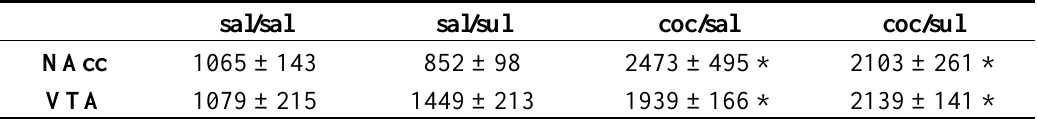
Table 2. Locomotor activity levels during reinstatement. Scores denote mean ± SEM. * differs from